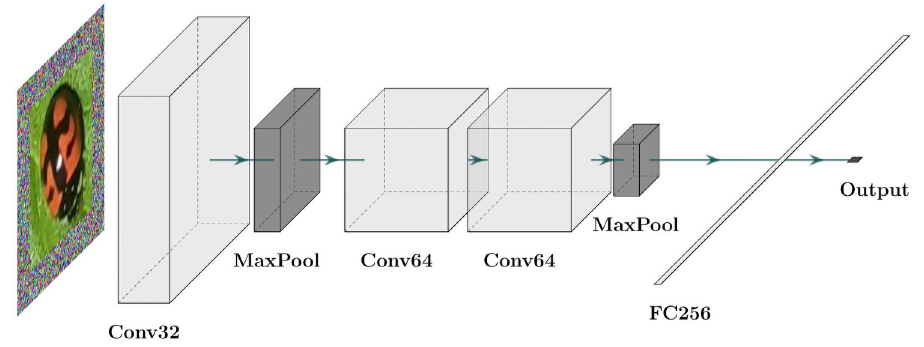
Fig 3. Proposed DCNN1 model.